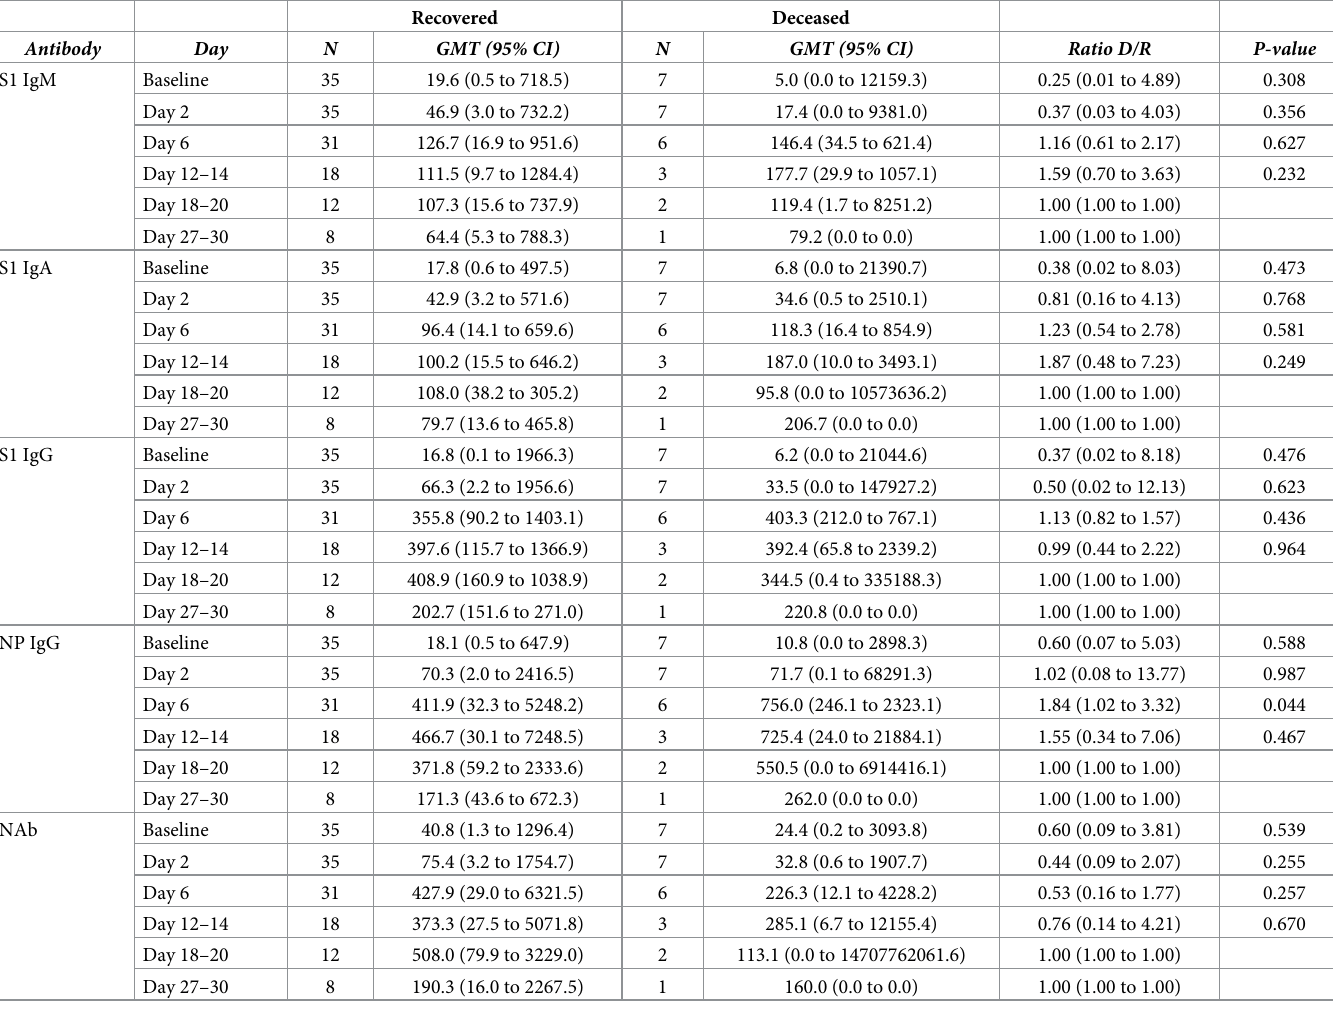
Table 2. Comparison of immune responses in recovered versus deceased COVID-19